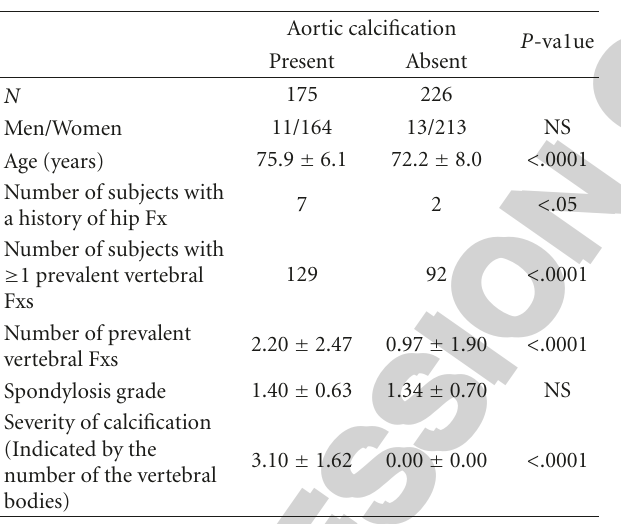
Table 2: Characteristics of the study subjects according to the presence of abdominal aortic calcification. Aortic calcification P -va1ue Present Absent